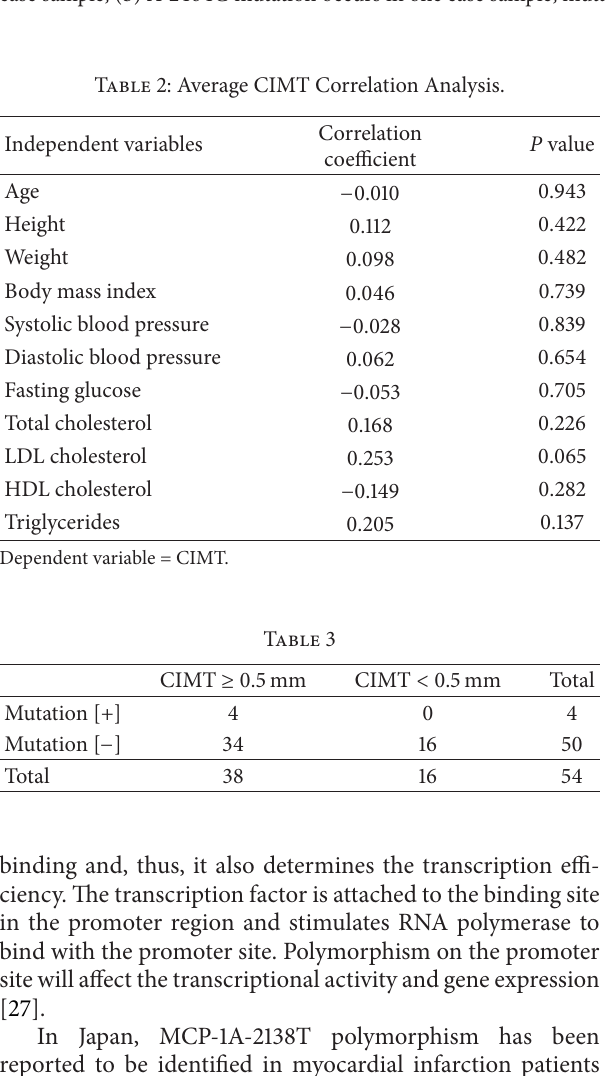
Figure 2: Mutation analysis results using Seqman program (DNASTAR): (a) A-2138T mutation occurs in two controlled samples and one case sample; (b) A-2464G mutation occurs in one case sample; mutation is shown by arrow.